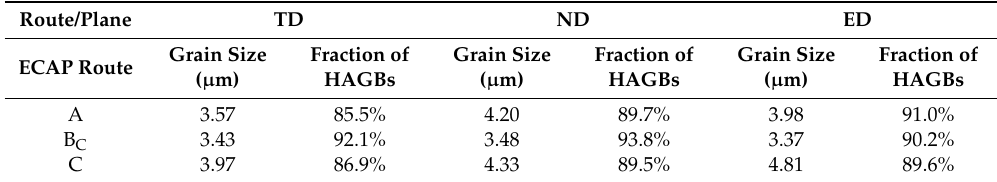
Figure 3. Inverse pole figure maps obtained for the particular planes and ECAP routes. Table 1. Average grain sizes and fractions of high angle grain boundaries for particular ECAP routes and planes, as estimated from EBSD measurements.